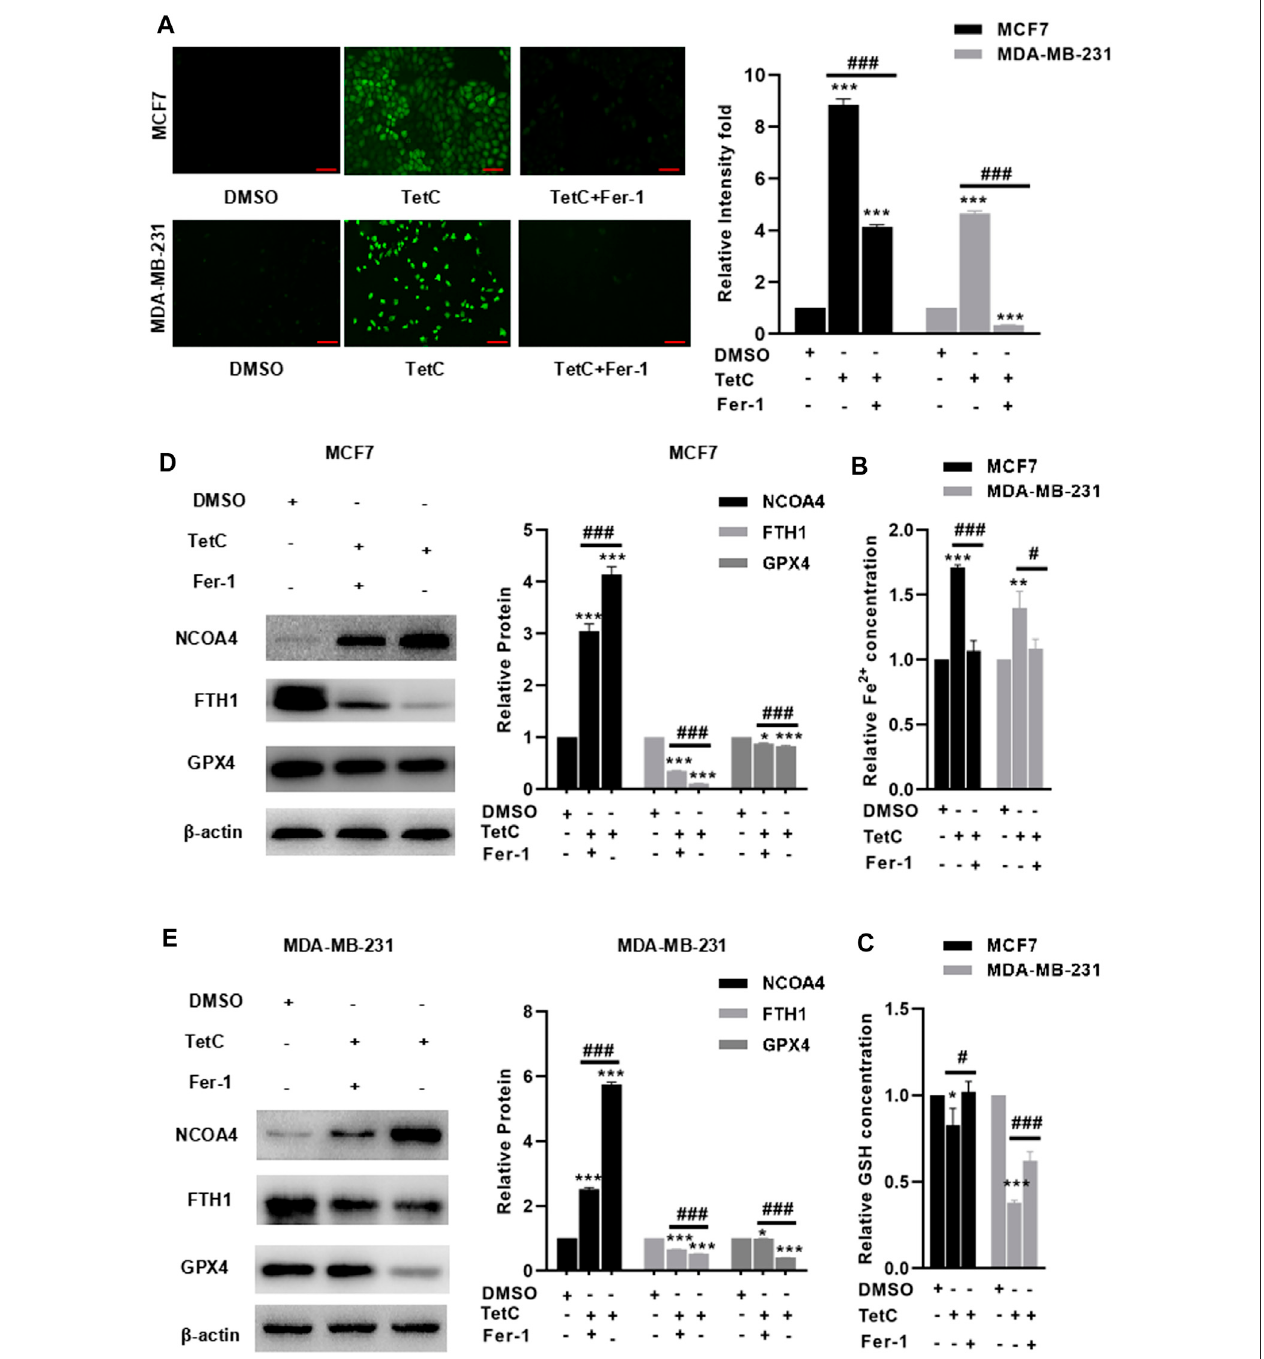
FIGURE7| Fer-1alleviatesTetC-inducedferroptosisinBCcells.PreincubationwithFer-1signi fi cantlyreducedtheintracellularROS (A) andFe 2+ (B) inbothMCF7 andMDA-MB-231cellstreatedwithTetC;scalebar,100 µm. (C) TherewasanincreaseinGSHintheTetC-treatedgroup,butadditionofFer-1obviouslyreversedsuch an effect. Fer-1 treatment signi fi cantly antagonized TetC-induced elevation of NCOA4 and downregulation of GPX4 and FTH1 in MCF7 (D) and MDA-MB-231 (E) cells. * p < 0.05; ** p < 0.01; *** p < 0.001 vs DMSO; # p < 0.05; ### p < 0.001 vs TetC alone.